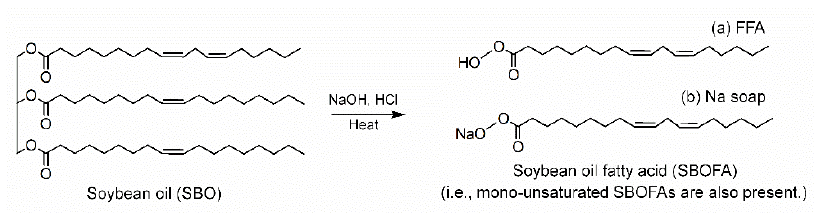
Figure 2. Hydrolysis reaction of SBO and its hydrolyzed products.